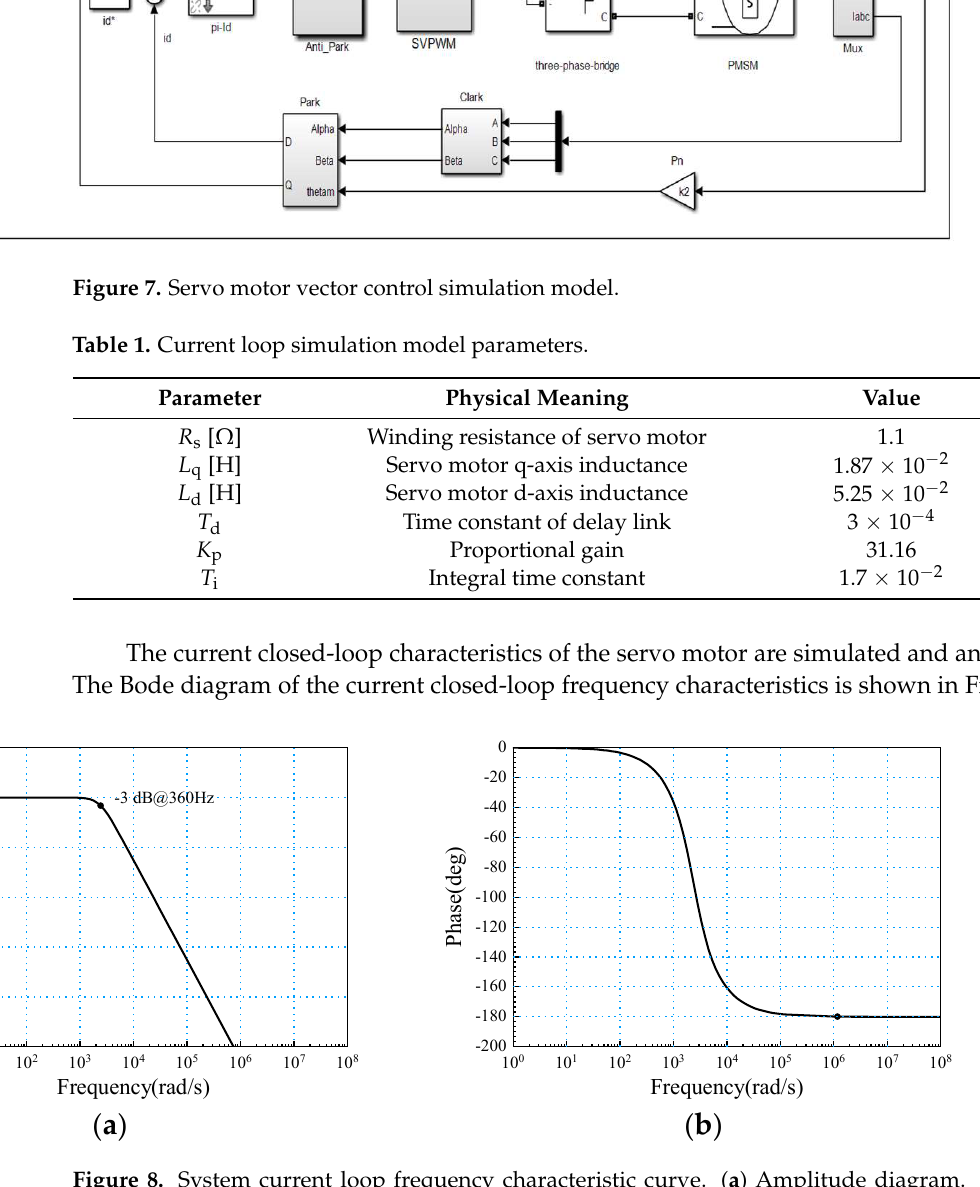
Figure 9. Servo motor dynamic block diagram. Based on the logic relation of high-frequency dynamics, the bandwidth of the inner current loop is much larger than that of the speed loop; therefore, the current loop as the inner current loop can be degraded, and the current loop as a whole is equivalent to a first-order inertia link: 1